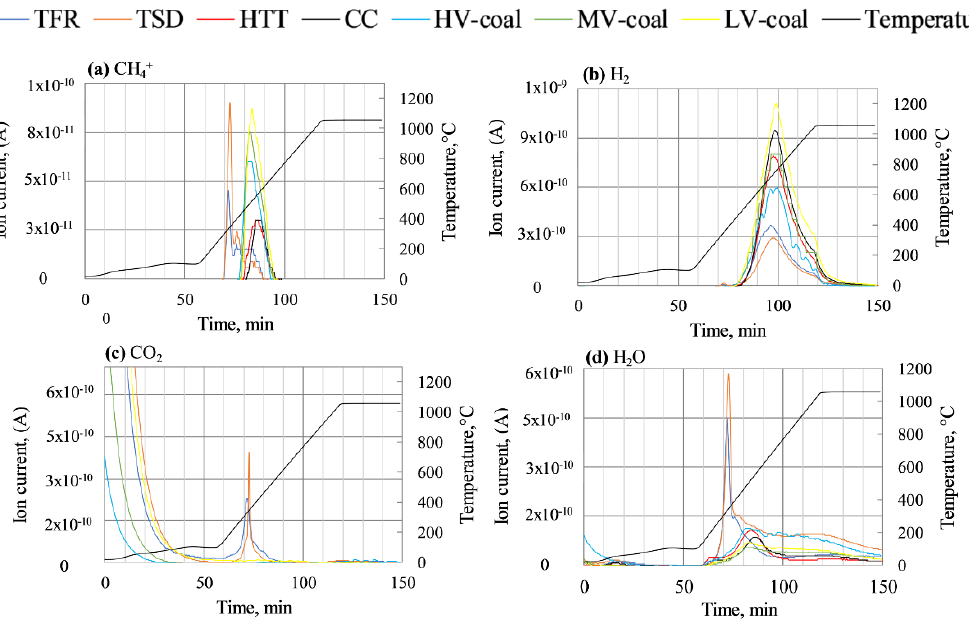
Figure 5. Off gas analysis of ( a ) CH + ; ( b ) H 2 ; ( c ) CO 2 ; and ( d ) H 2 O for different types of bio-coals and coals at carbonization conditions in N 2 atmosphere.